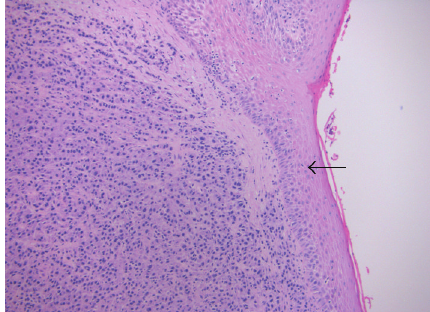
Figure 3: Tonsillar tissue with intact surface squamous epithelium (arrow) and underlying di ff use infiltrate of neoplastic plasma cells (H & E stain, x10).